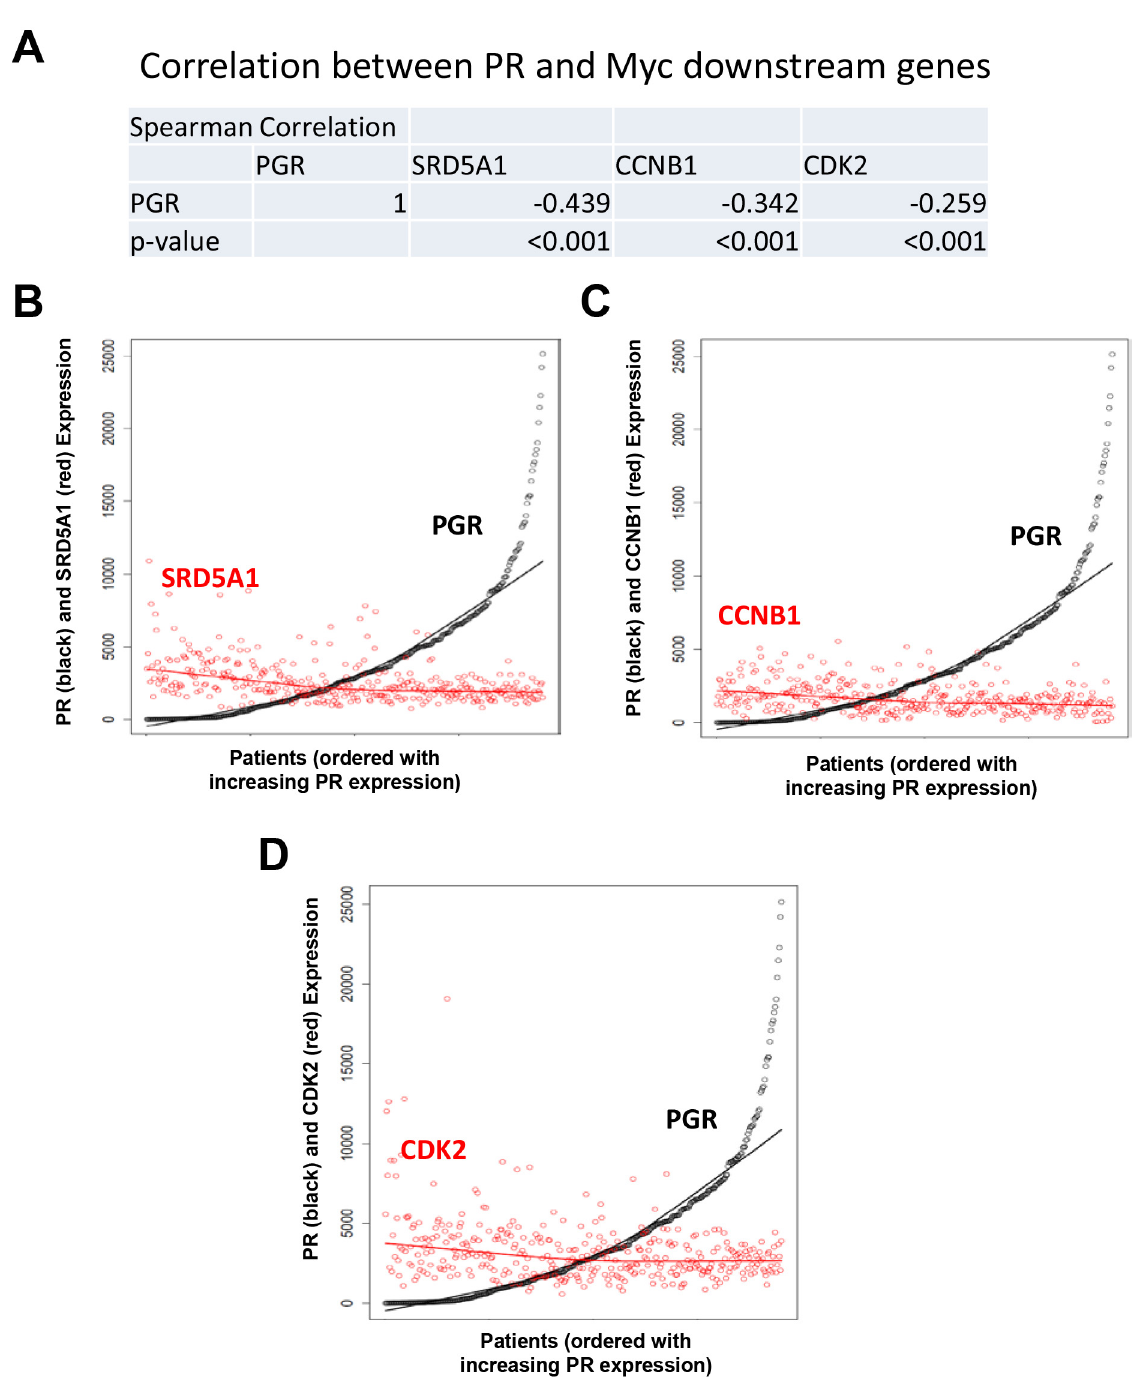
Fig 8. Inverse correlation of PR with Myc target genes in endometrial cancer TCGA data. (A) Pairwise correlation analysis of PGR and Myc downstream genes, SRD5A1, CCNB1 and CDK2 using Spearman method. The correlation coefficients and p values are shown. (B-D) Scatterplots to show the positive or negative correlation of expression of two genes as in Fig 6C. (B) Expression of SRD5A1 (red) against PGR (black); (C) expression of CCNB1 (red) against PGR (black); and (D) expression of CDK2 (red) against PGR